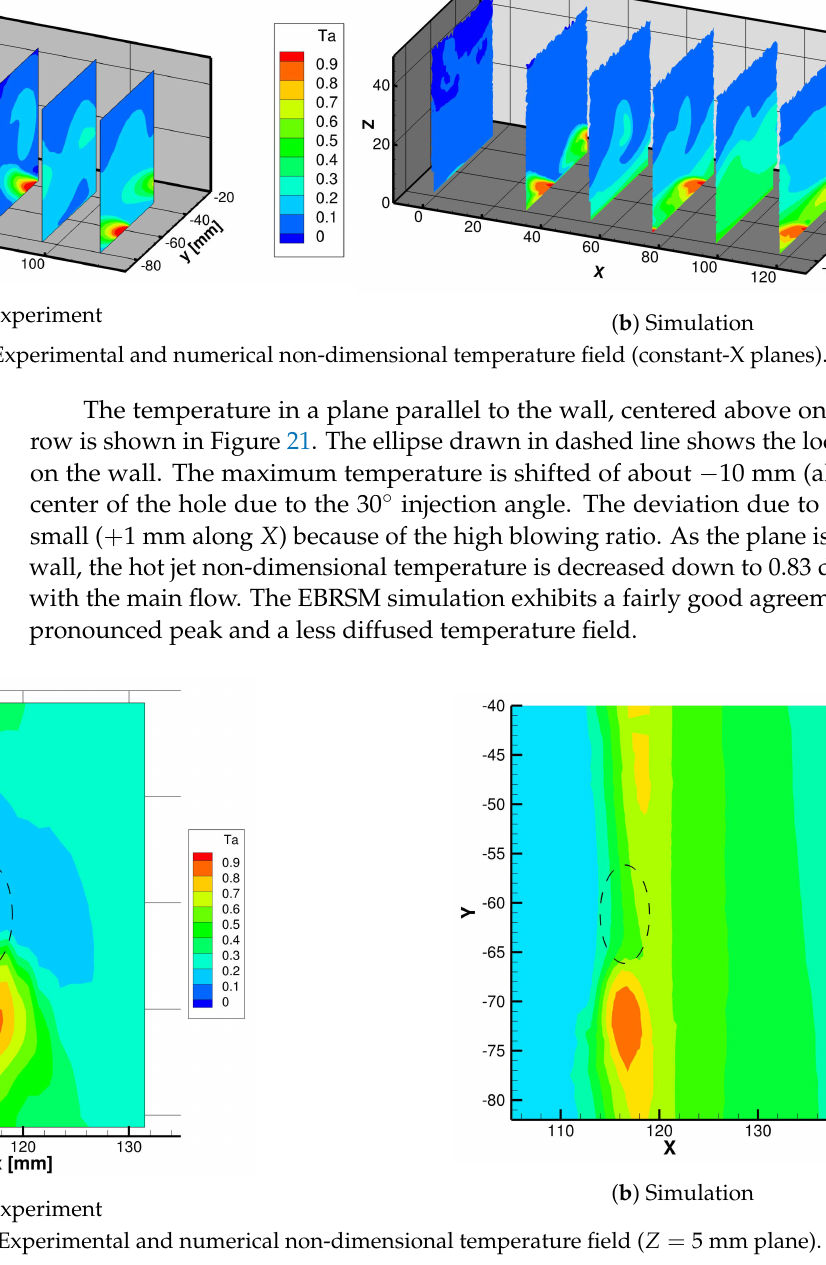
Figure 21. Experimental and numerical non-dimensional temperature field ( Z = 5 mm plane). The constant-Y plane at the center of the measurement box is shown in Figure 22. The three small rectangles in dashed line represent the three injection holes positions. Only the first and third rows are in the measurement plane. The temperature map clearly shows a maximum equal to 1 located at these two injection points, as the jets cross the measurement plane. At the second row the trace of the jet coming from the hole at Y = − 41.0 mm is visible about 10 mm above the wall, with a reduced maximum (0.53) due to mixing of the hot jet with the main cold flow. The trace of the jet coming from the hole at Y = − 20.9 mm